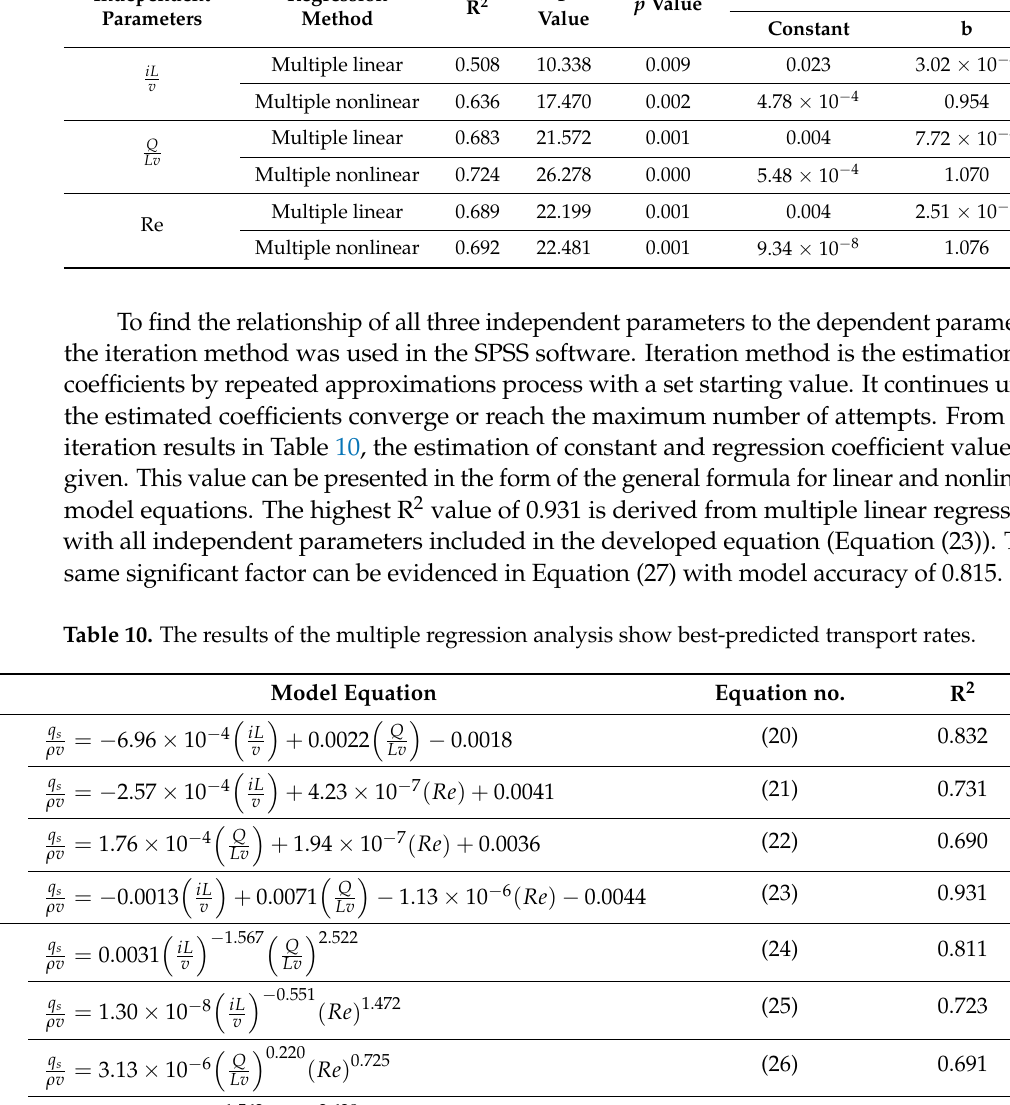
Table 9. Results from the curve estimation analysis for dependent parameter q s